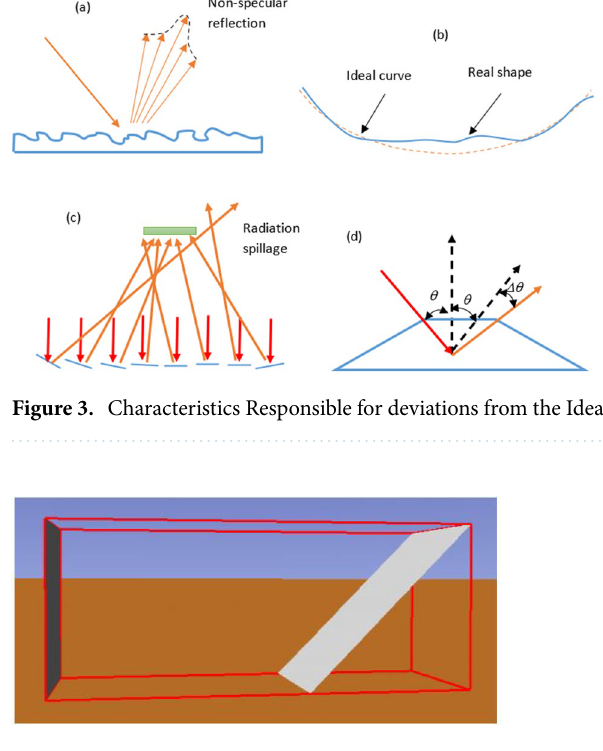
Figure 4. Simulation environment for a flat concentrator: receiver on the left of the flat concentrator.